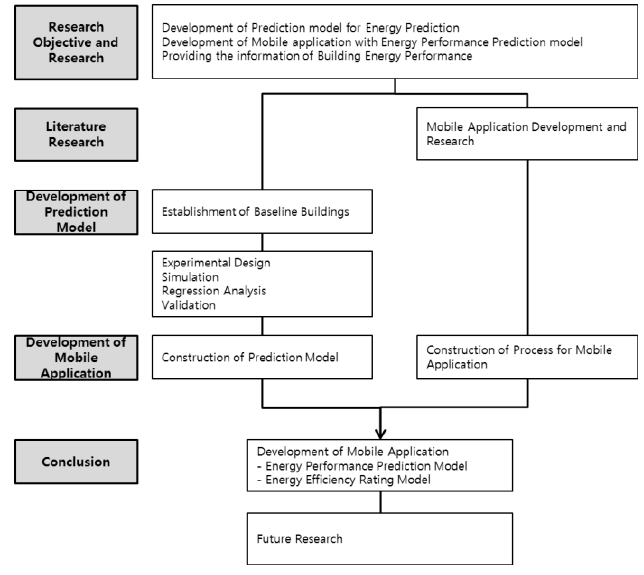
Figure 1. The research flow chart.